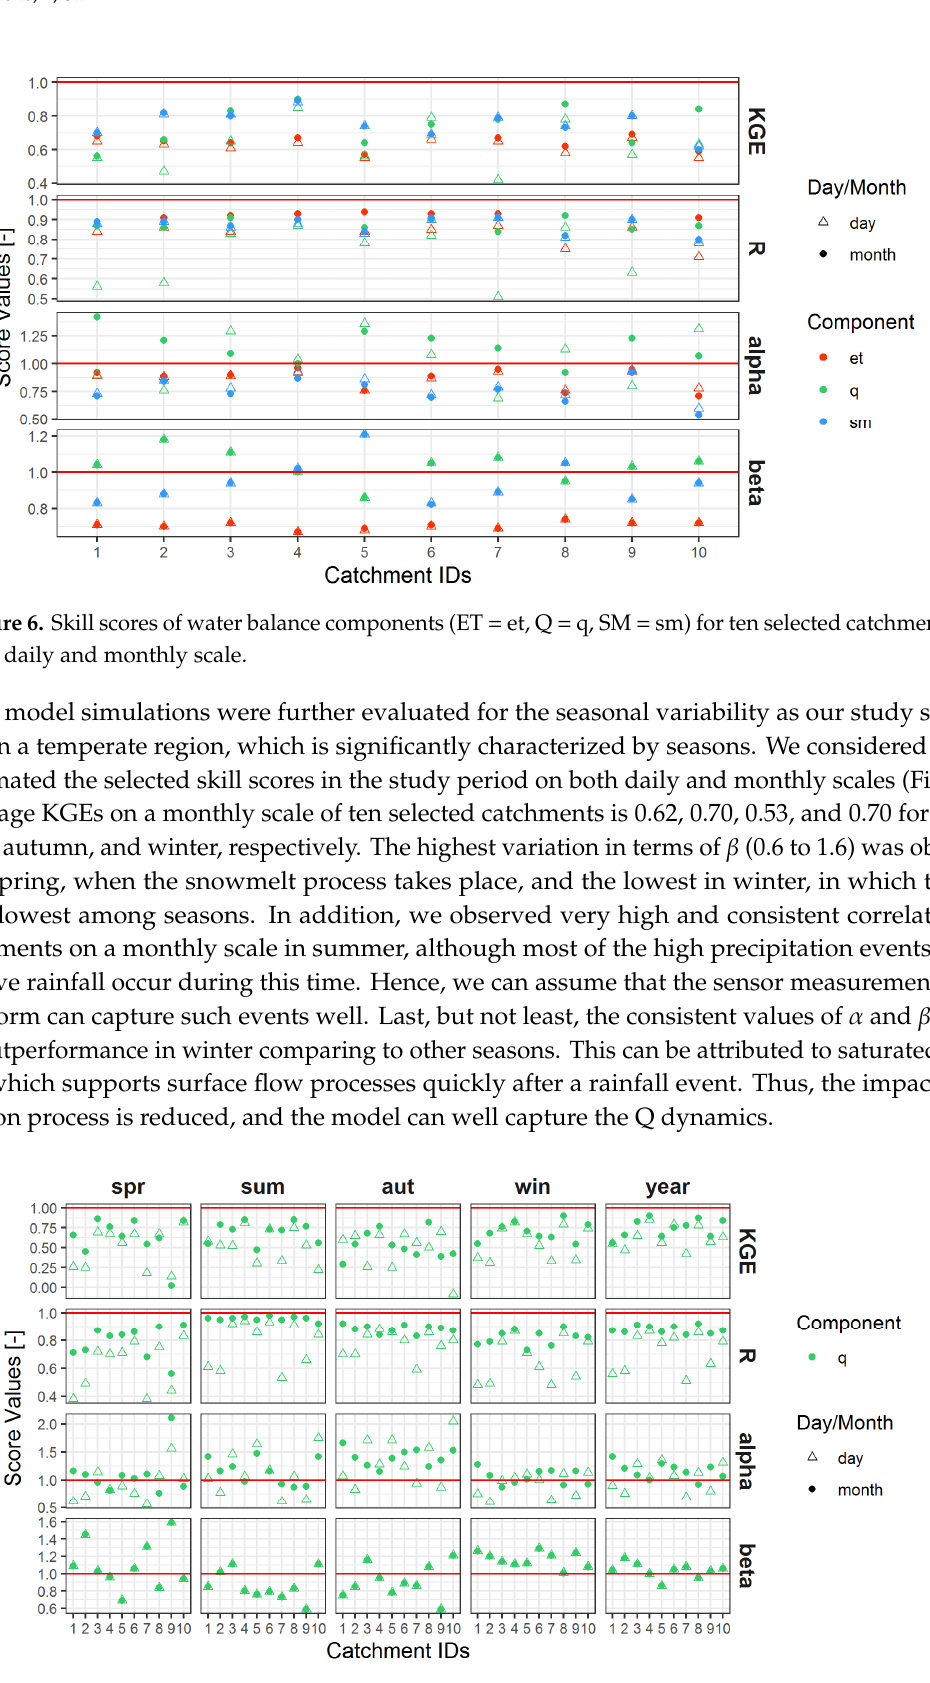
Figure 7. Skill scores of the seasonal variation for Q for ten selected catchments on a daily and monthly scale. The seasons are defined as spring (spr) March to May, summer (sum) June to August, autumn (aut) September to November, and winter (win) December to